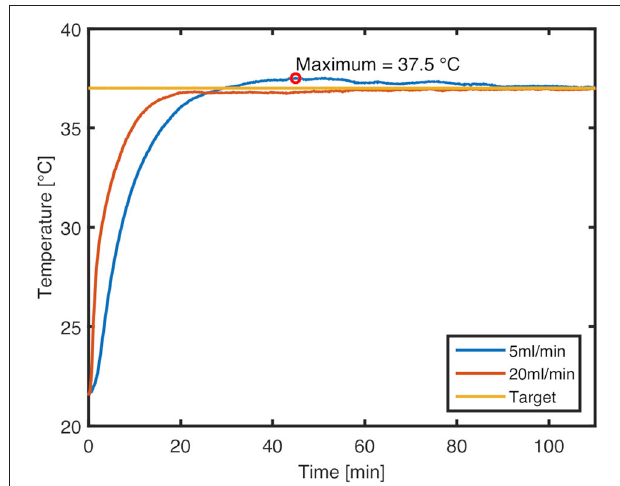
FIGURE 6 | Characteristic temperature profiles for ramp-up to 37 ◦ C set temperature at flow rates of 20 and 5 ml/min, respectively. An overshoot of 0.5 ◦ C is seen at the lower flow